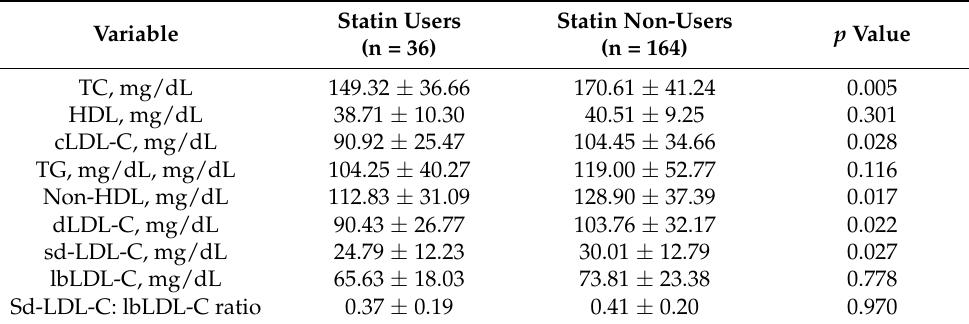
Table 6. Lipid profile comparison according to patients’ statin